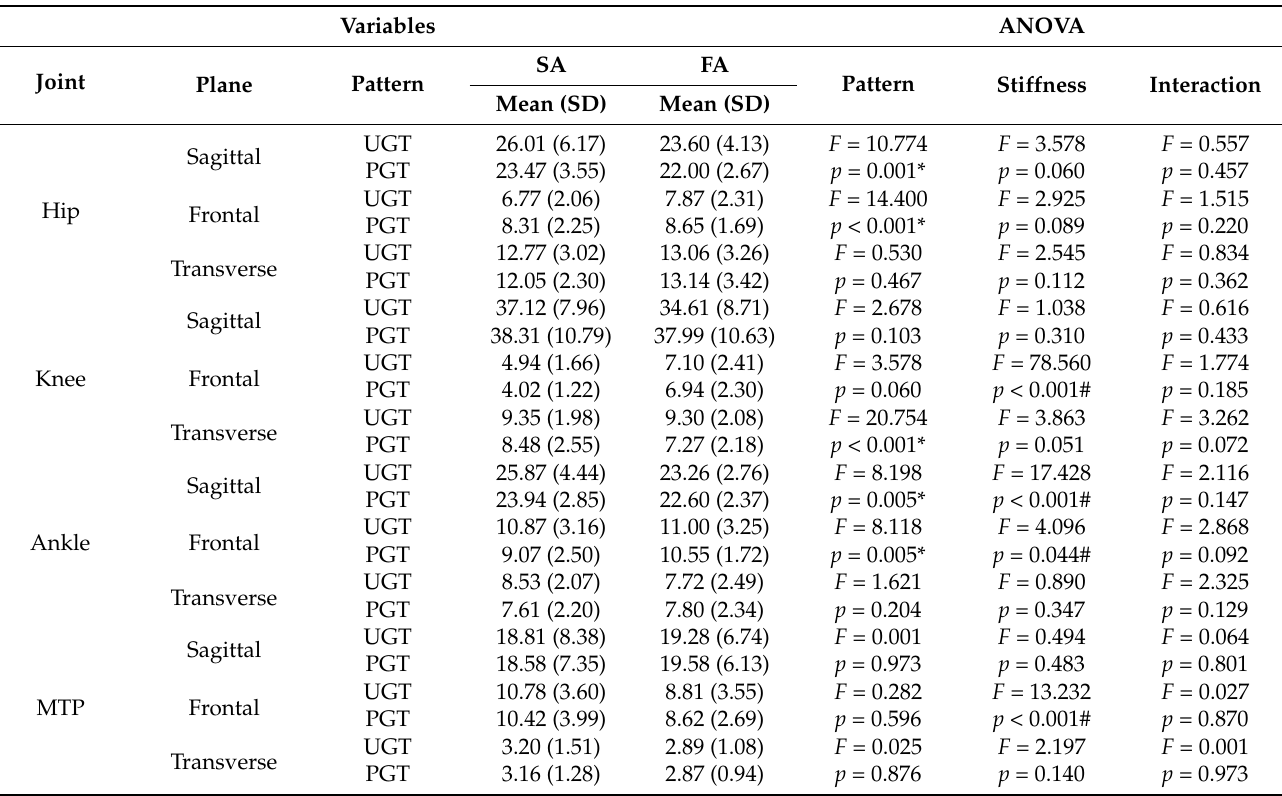
Table 1. Lower extremity joints’ range of motion (ROM) from subjects with different arch stiffnesses during two types of gait